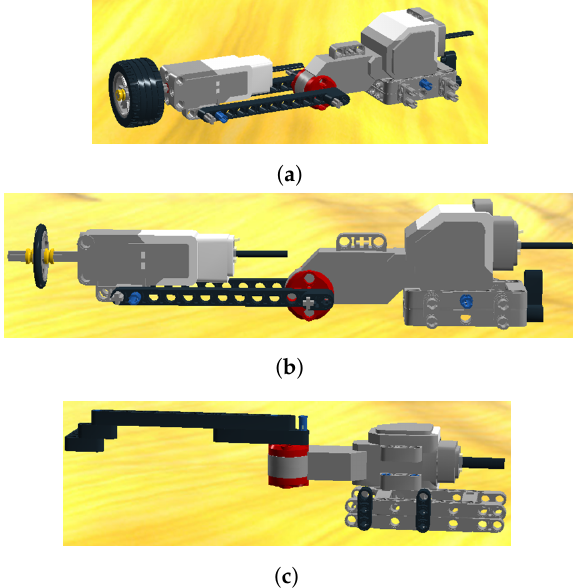
Figure 2. Lifting and turning arms. ( a ) Lifting arm with thick wheel; ( b ) Lifting arm with thin wheel; ( c ) Turning